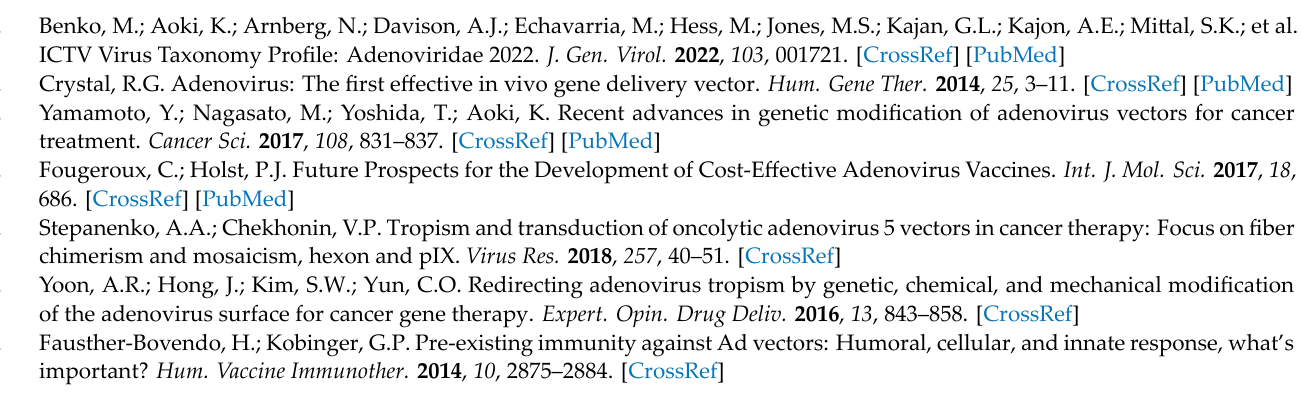
Figure S4: block the infection of F2CF1K‑CG or HAdV5‑CG to HEp‑2 cells with recombinant CELO fiber1